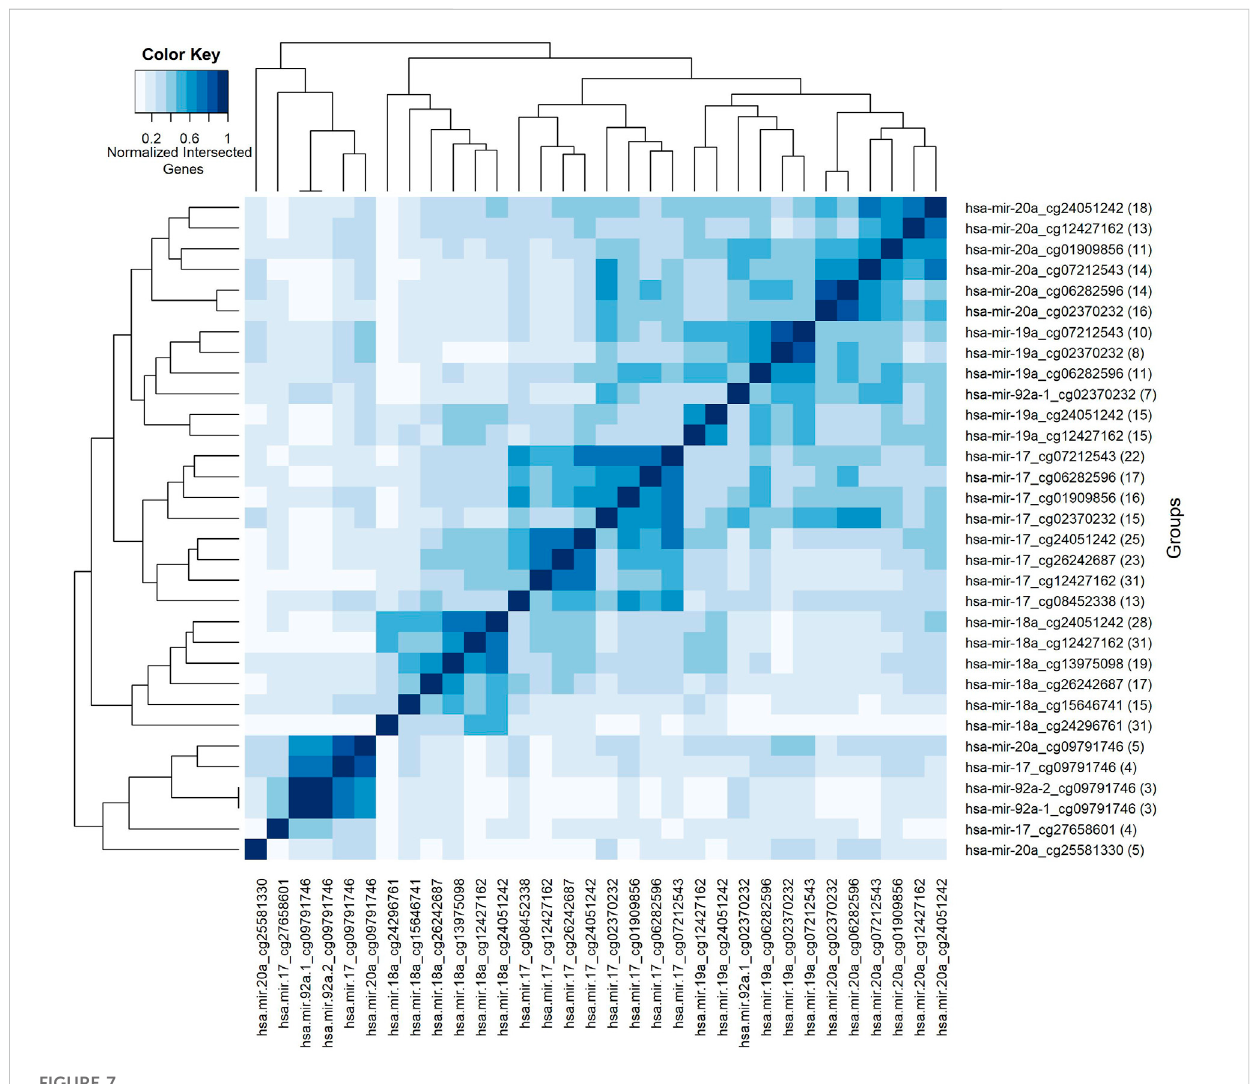
FIGURE 7 Heatmap of group features based on normalized intersected genes among each pair of groups. Color key encodes normalized intersected gene numbers for each pair of groups. Scale 1 indicates group pairs with most normalized shared gene numbers.